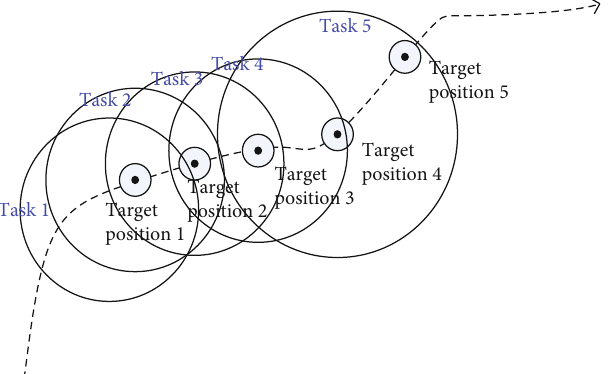
Figure 11: Observation model of swarm moving target tracking